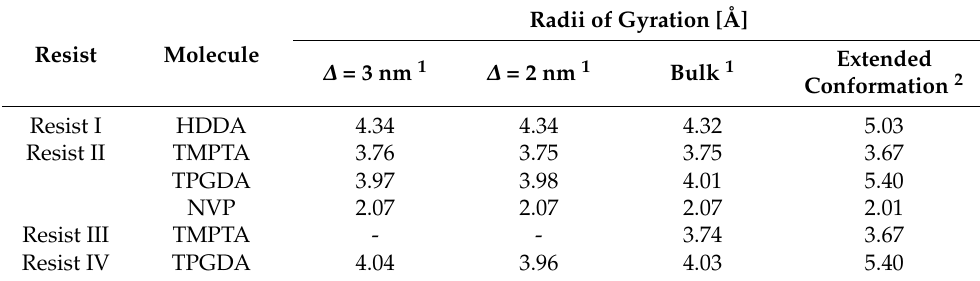
Radii of Gyration